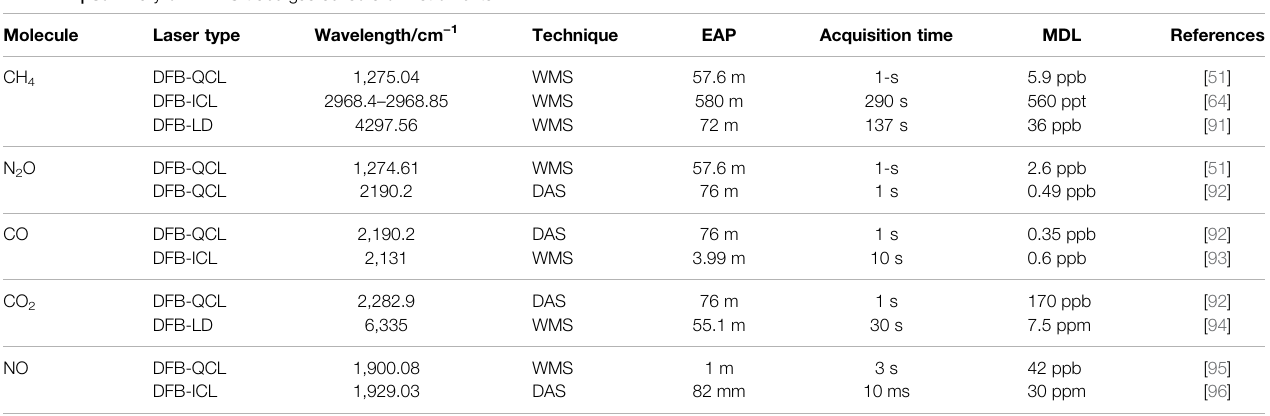
TABLE 1 | Summary of TDLAS trace gas sensors or